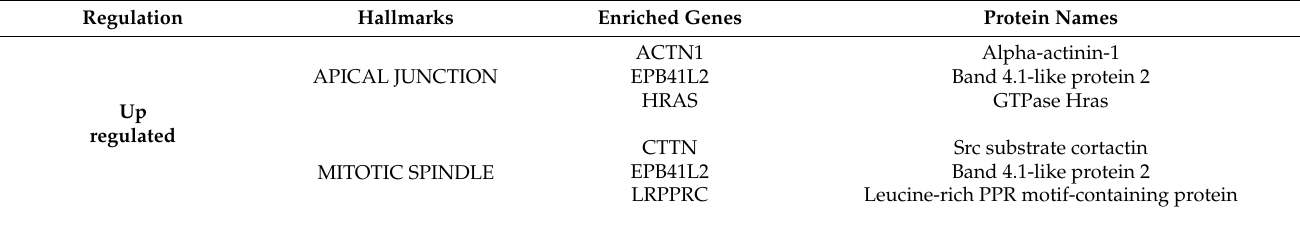
Table 2. Enriched pathways using the 144 DEPs of